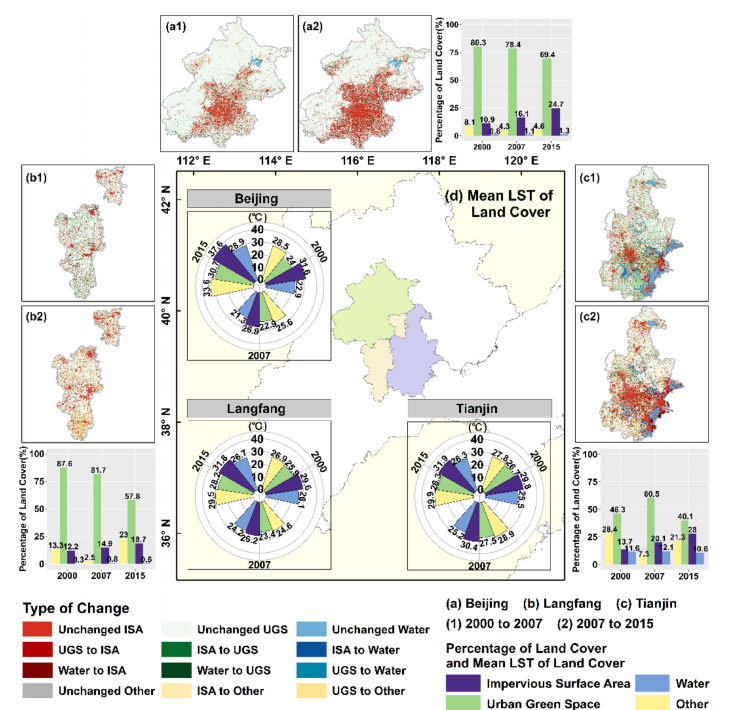
Figure 4. Changes of LSC within Beijing, Tianjin and Langfang from 2000 to 2015, percentage of different LSC and the LST related to each LSC.